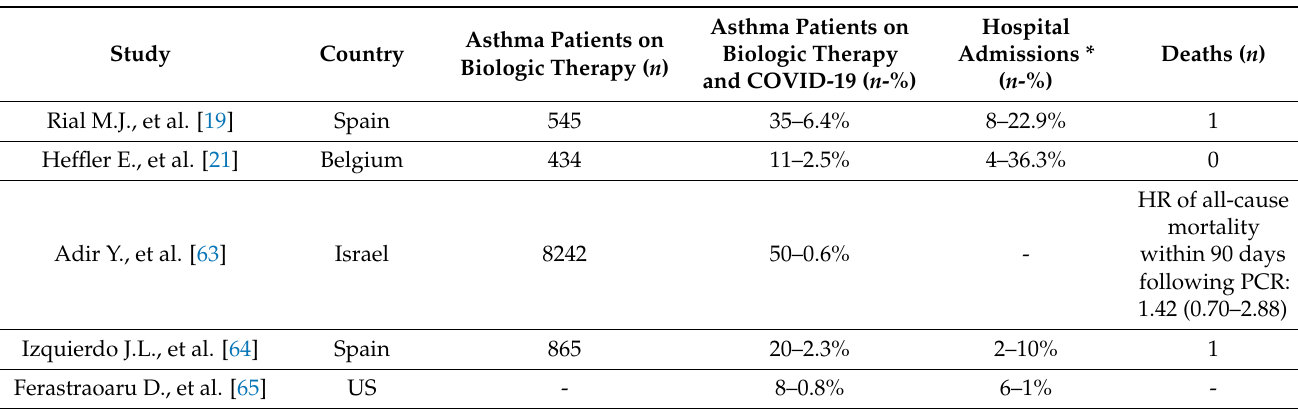
Table 3. COVID-19 and severe asthma on biologic